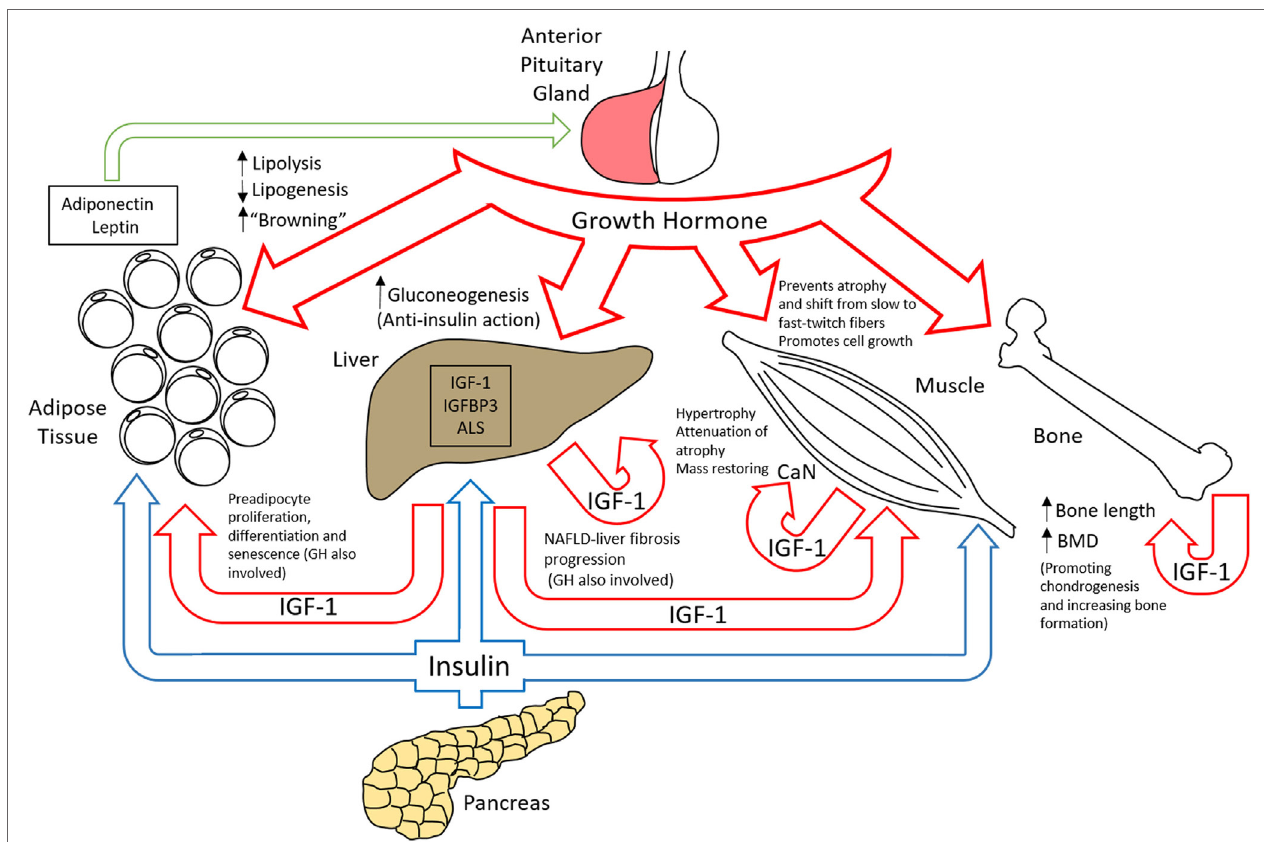
FiGURe 6 | Organ-specific roles of the GH/insulin-like growth factor-1 (IGF-1)